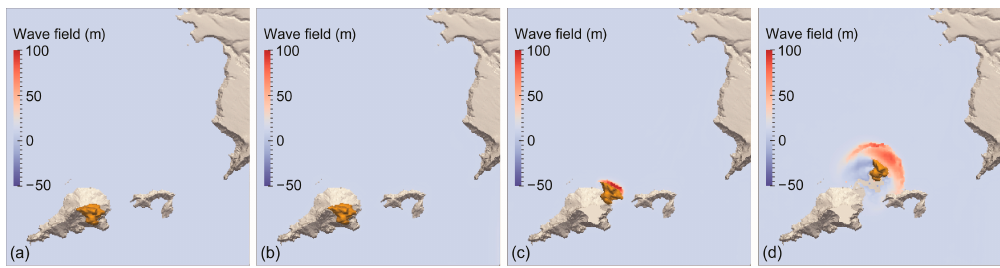
Figure 4. Time history of the slide velocity and position for ( a ) scenario 1 and ( b ) scenario 2; the landslide fronts reach the water surface at position = 0 m and t = 0 s.